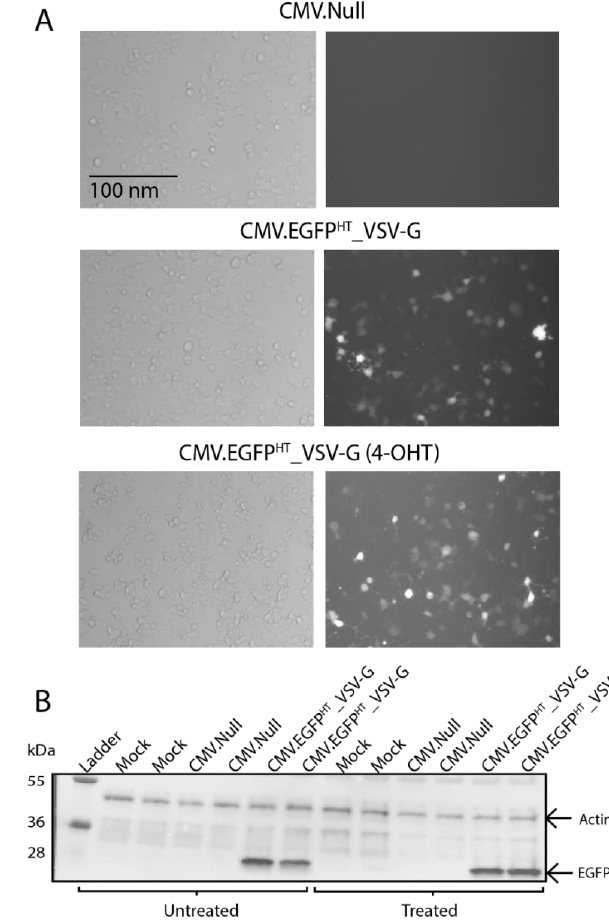
Figure 5. ( A ) bright field (left) and fluorescence (right) images of tamoxifen-treated (4-OHT)